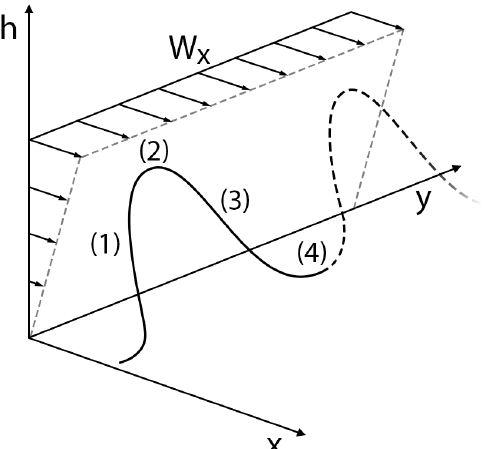
Figure 2. Typical dynamic soaring trajectory with a linear wind gradient (adapted from [5]). From the initial formulation by Zhao [5], the horizontal wind profile from which energy is extracted can be modeled through a horizontal wind speed W x , represented by a shape parameter A x , an average gradient slope β x , a maximum wind speed W max transitional altitude h tr x